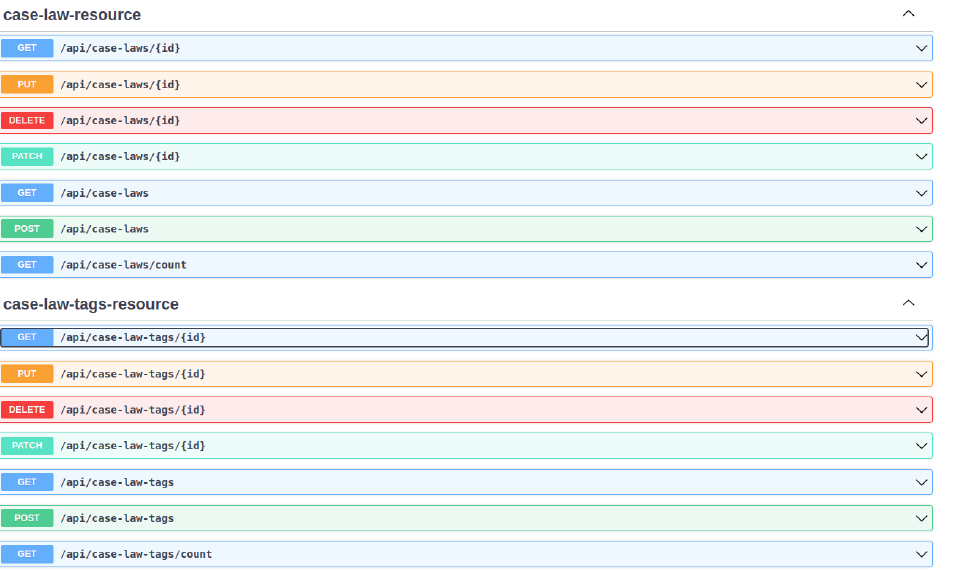
Figure A2. Our REST API’s documentation interface. The screen capture displays the interface for two entities of our